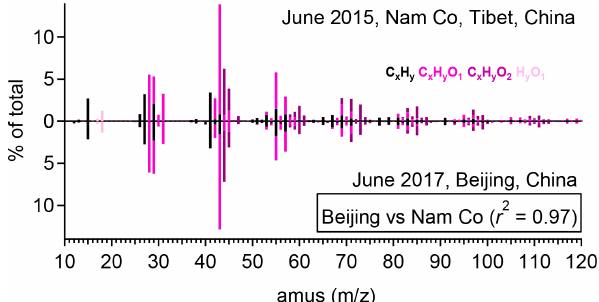
Figure 5. Comparison between the high-resolution mass spectra of A-BBOA obtained in Nam Co (June 2015) and Beijing (June 2017) (nitrogen-containing ions are not shown